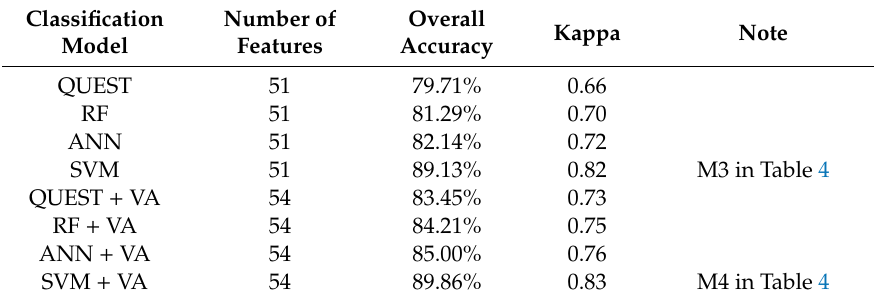
Table 6. Accuracy assessment of classifications comparing di ff erent machine learning classifiers.